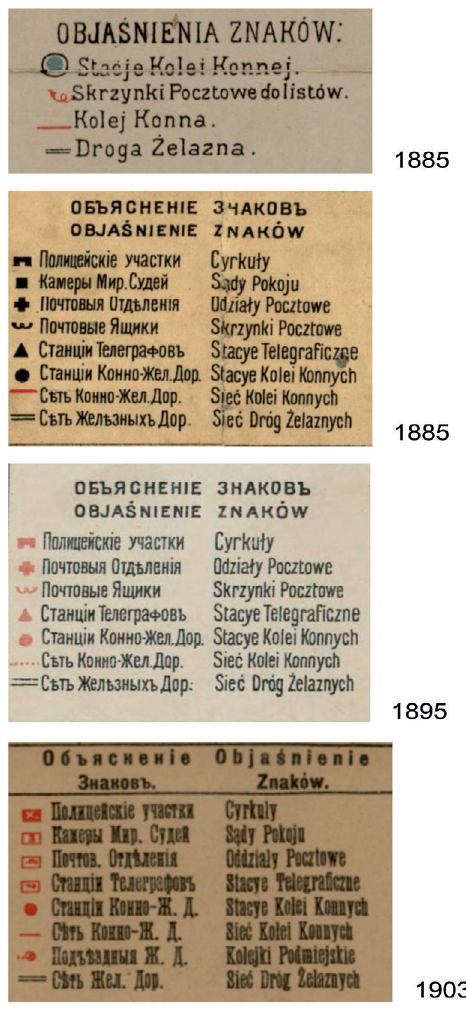
Fig. 3. Legends of selected city maps of Warsaw produced by F.